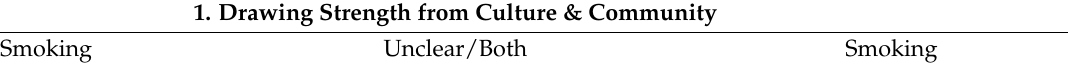
Table 2. Summary of all reasons for smoking/non-smoking by key themes. 1. Drawing Strength from Culture &